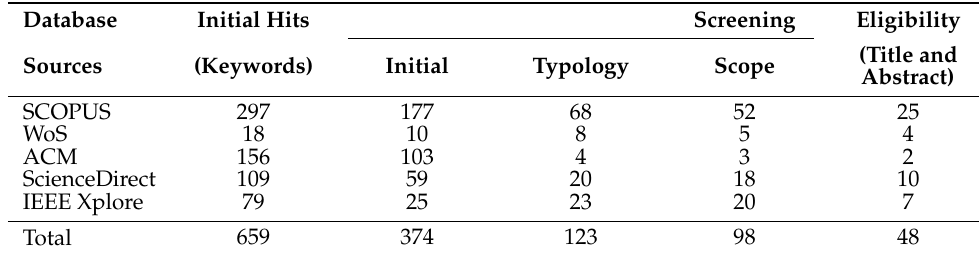
Table 3. The results of the keyword search by scientific database.